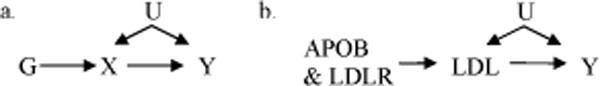
Typical instrumental variable setup. G is an instrument. X is a possible cause for Y. U is all unmeasured confounders.